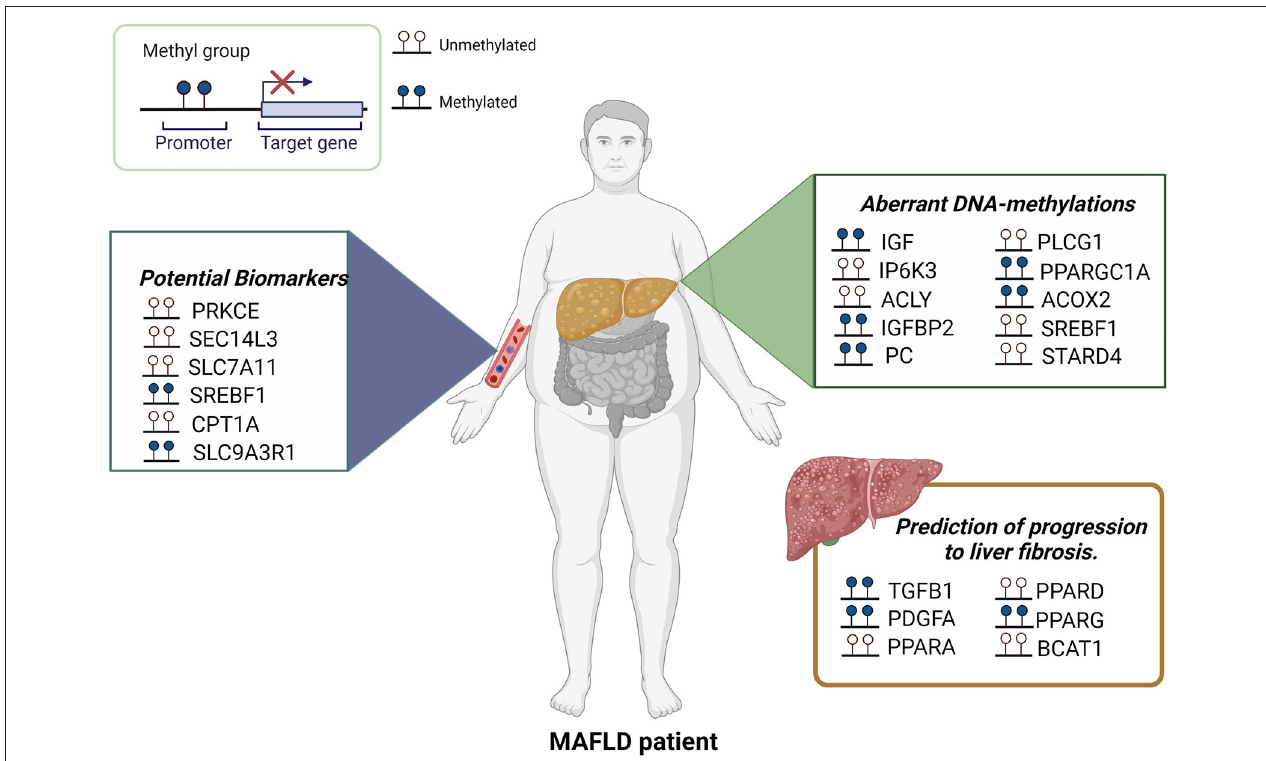
FIGURE 1 | Aberrant DNA-methylations in MAFLD. Several studies using liver biopsies, ccf-DNA or peripheral blood leukocytes have been shown differential DNA methylation patterns associated with MAFLD. Certain CpGs also represent attractive biomarkers for MAFLD and the prediction of progression to